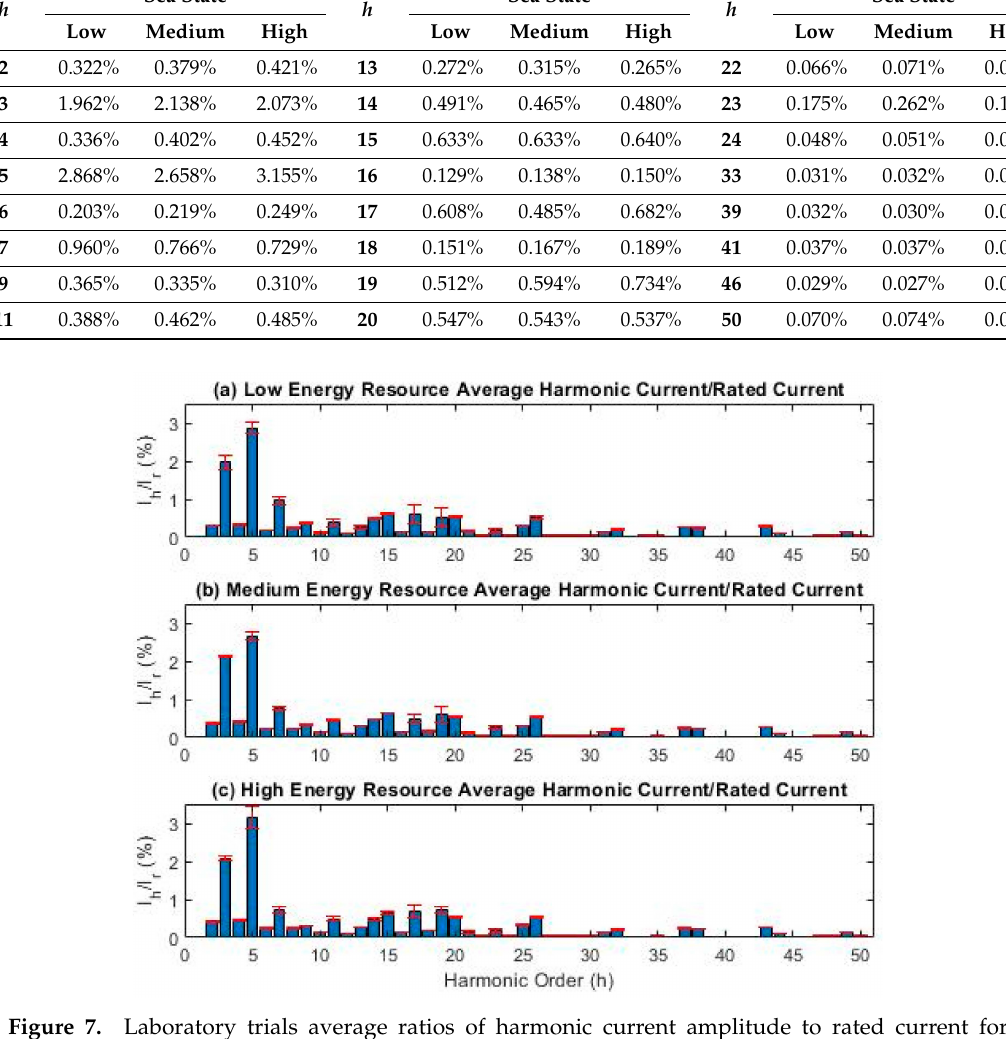
Figure 7. Laboratory trials average ratios of harmonic current amplitude to rated current for ( a ) low energy, ( b ) medium energy, and ( c ) high energy resource classifications, including error bars, which represent the standard deviation of the data